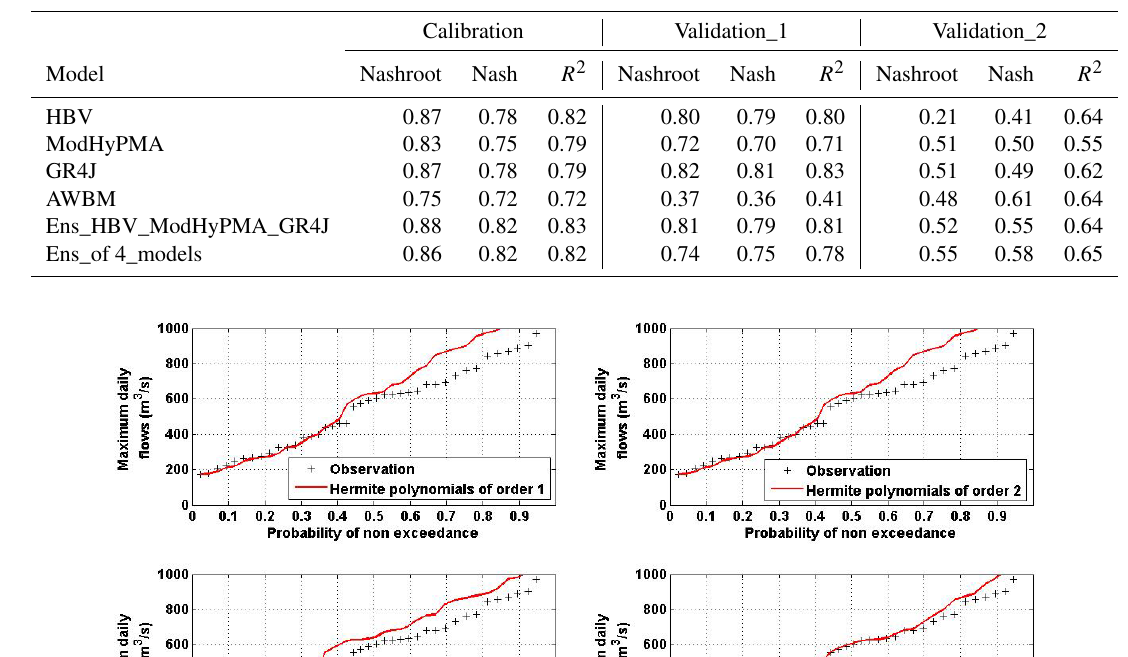
Table 2. Performance of the rainfall-runoff.